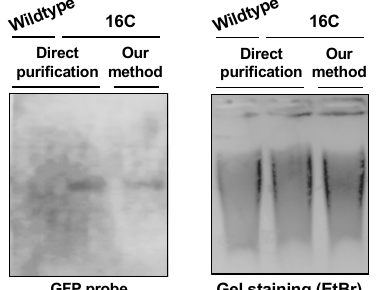
Figure 2. Southern blots for detecting GFP cDNA, with ethidium bromide staining used as the loading control.